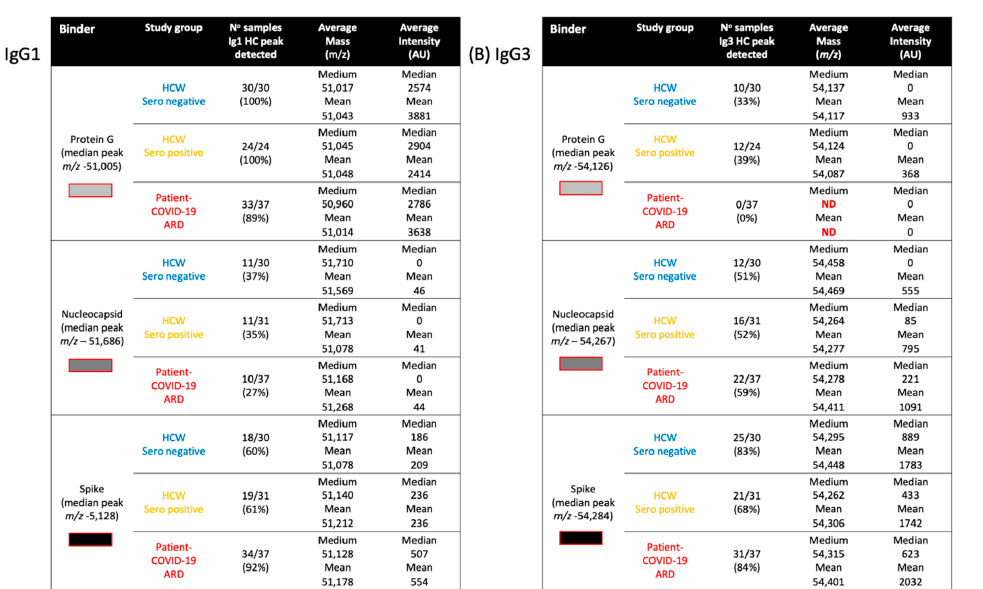
Figure 4. Comparative table of IgG1 ( A ) and IgG3 ( B ) spectral analyses: Detection frequency, intensity and molecular mass for all samples captured by protein G , nucleocapsid and prefusion complete spike protein . Further delineation is done by sample infection status: blue represents data from SARS-CoV-2 sero-negative HCWs, orange from SARS-CoV-2 sero-positive HCWs having recovered from mild symptoms and red sample data from convalescent patients re- covering from COVID-19